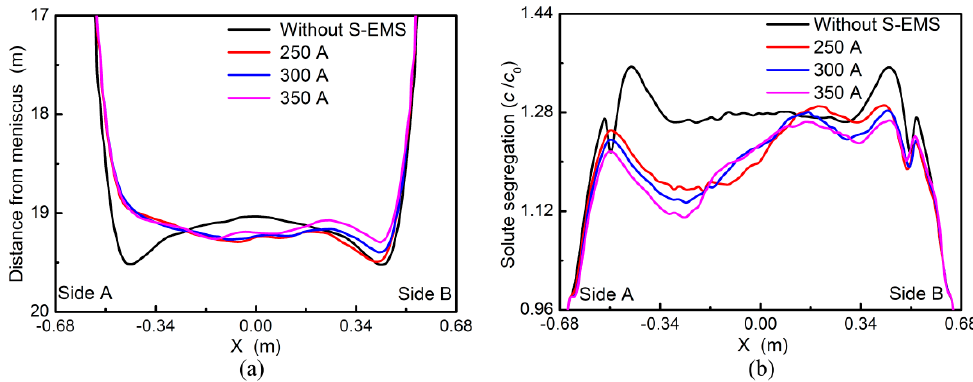
Figure 13. Solidification end profile ( a ) and centerline solute segregation ( b ) along the transverse direction with different current intensities.